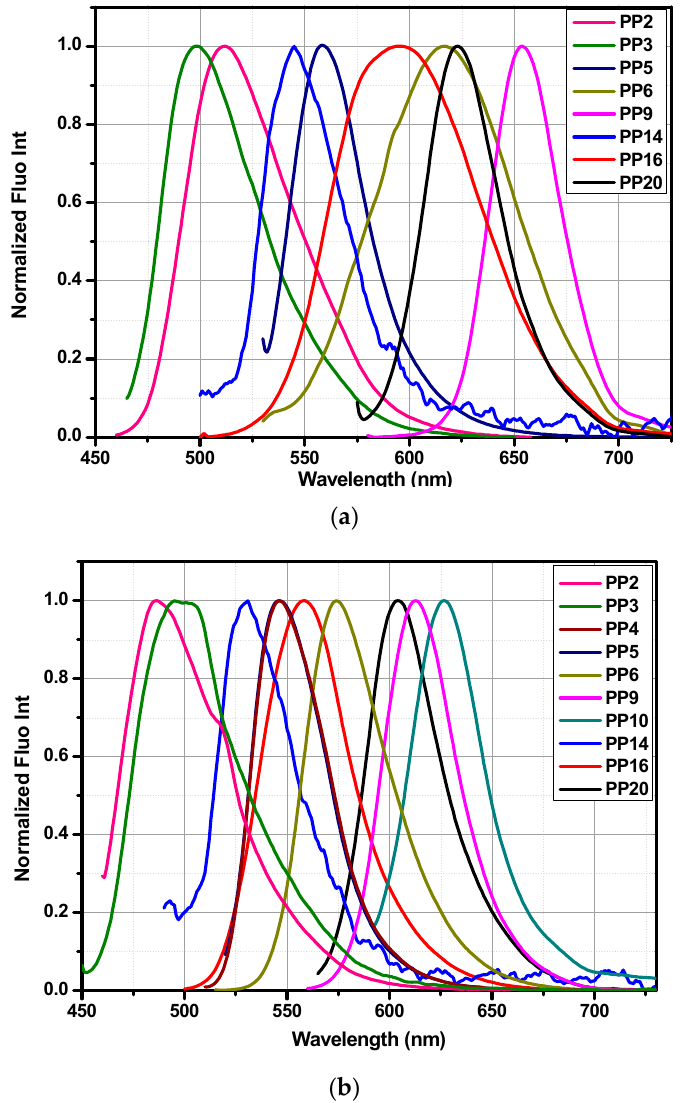
Figure 10. Fluorescence spectra of studied compounds in dichloromethane ( a ) and toluene ( b ). Table 5. Fluorescence properties of the different compounds in dichloromethane and toluene solutions.